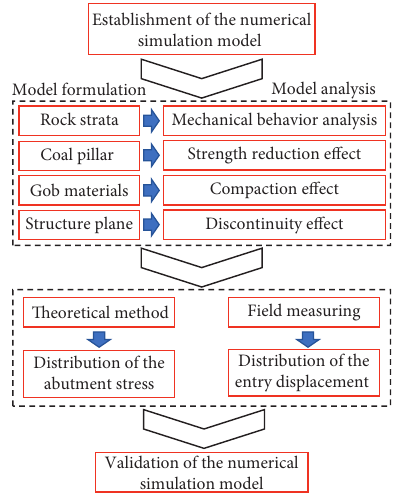
Figure 1: Formation process of the numerical simulation